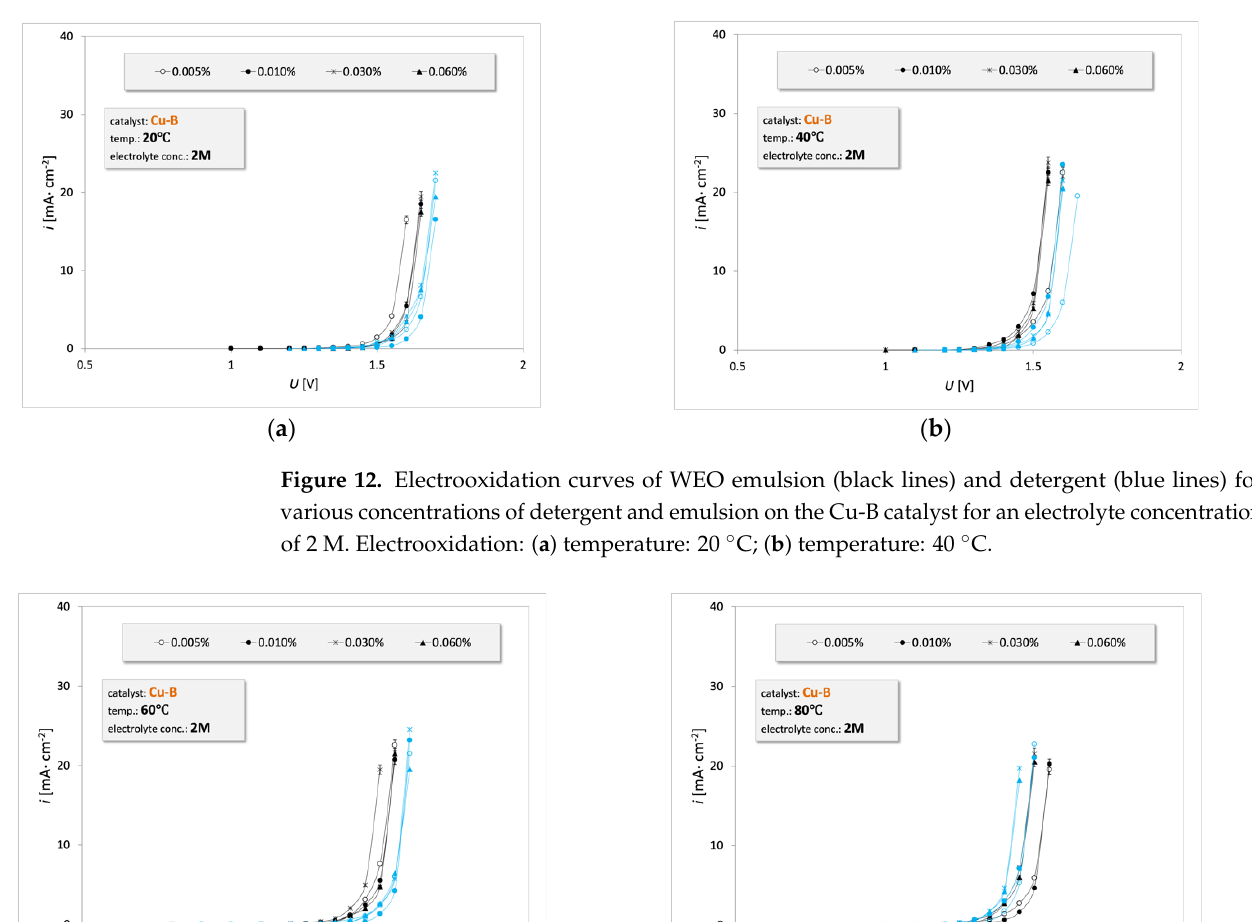
( b ) Figure 11. Electrooxidation curves of WEO emulsion (black lines) and detergent (blue lines) for var- ious concentrations of detergent and emulsion on the Cu-B catalyst for an electrolyte concentration of 0.5 M. Electrooxidation: ( a ) temperature: 60 °C; ( b ) temperature: 80 °C.